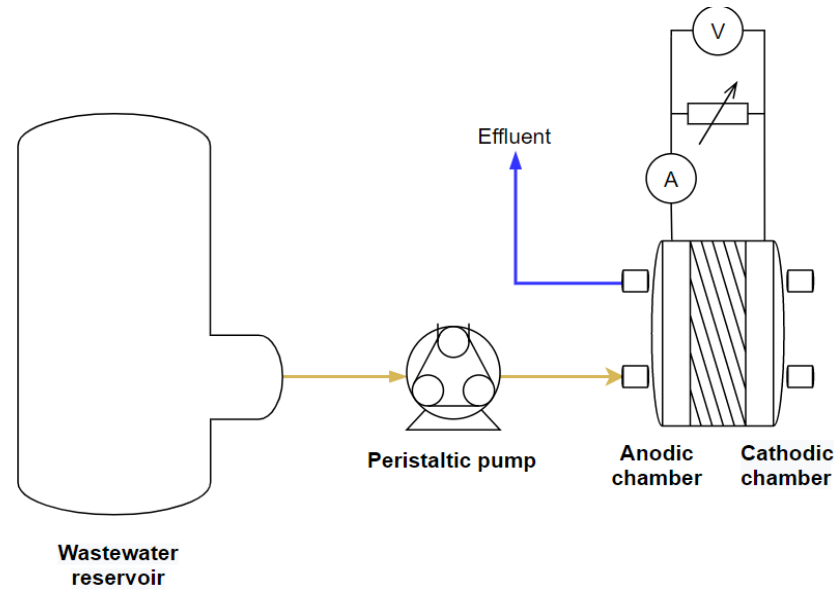
Figure 1. Set-up configuration.